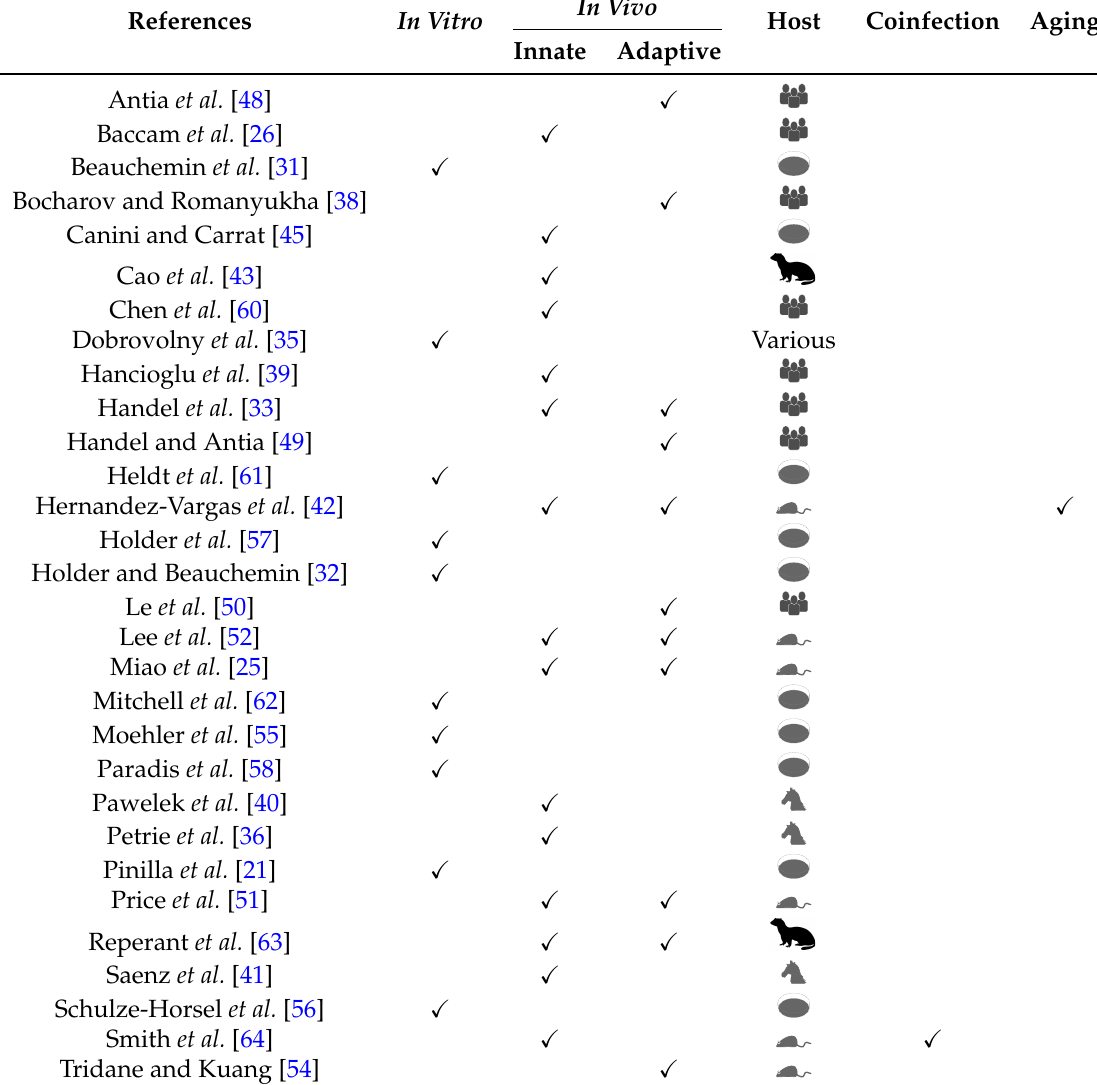
Table 1. Overview of the different mathematical models for IAV